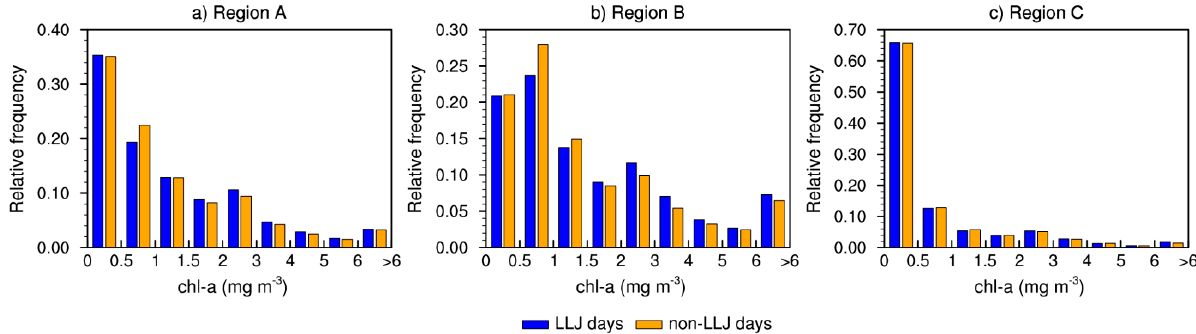
Figure 10. Probability density distribution of chl-a concentrations on LLJ and non-LLJ days in regions ( a ) A, ( b ) B, and ( c ) C (shown by the black boxes in Figure 4i).